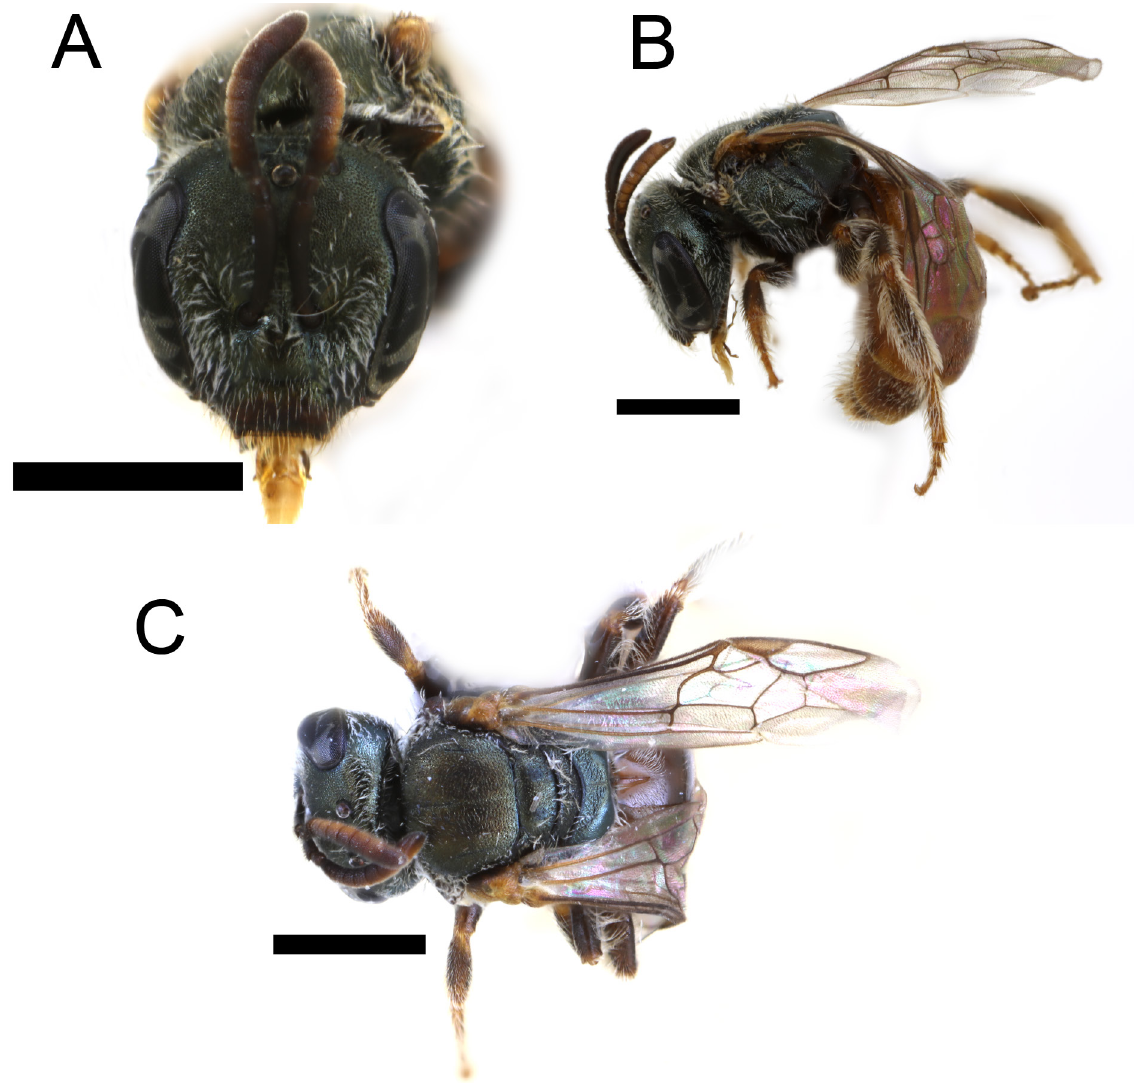
Fig. 12. Lasioglossum monense sp. nov., ♀. A . Face. B . Lateral habitus. C . Dorsal habitus. Scale bars = 1